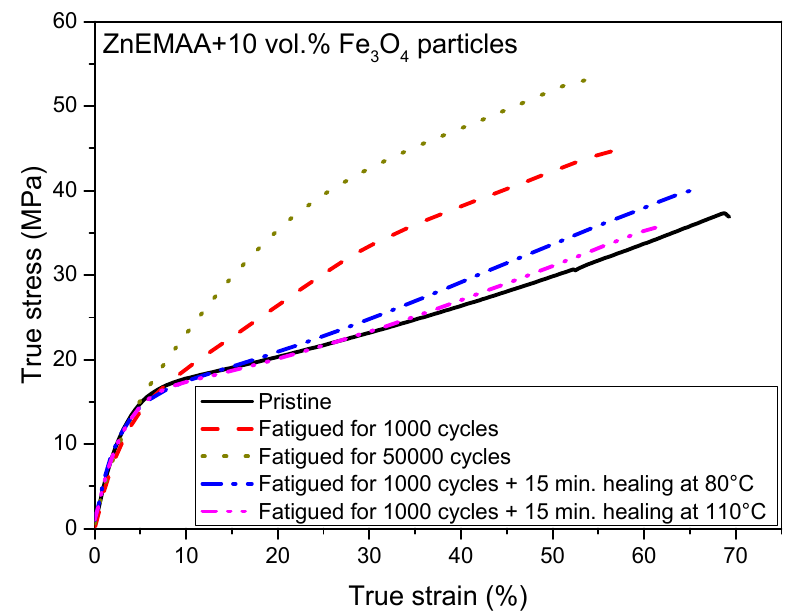
Figure 6. Stress–strain curves taken during the several stages of the fatigue damage-recovery process. It shows that the strain hardening increases when the number of applied fatigue cycles is increased from 1000 to 50,000 and that the original stress–strain relation can be restored when a heat treatment is applied.